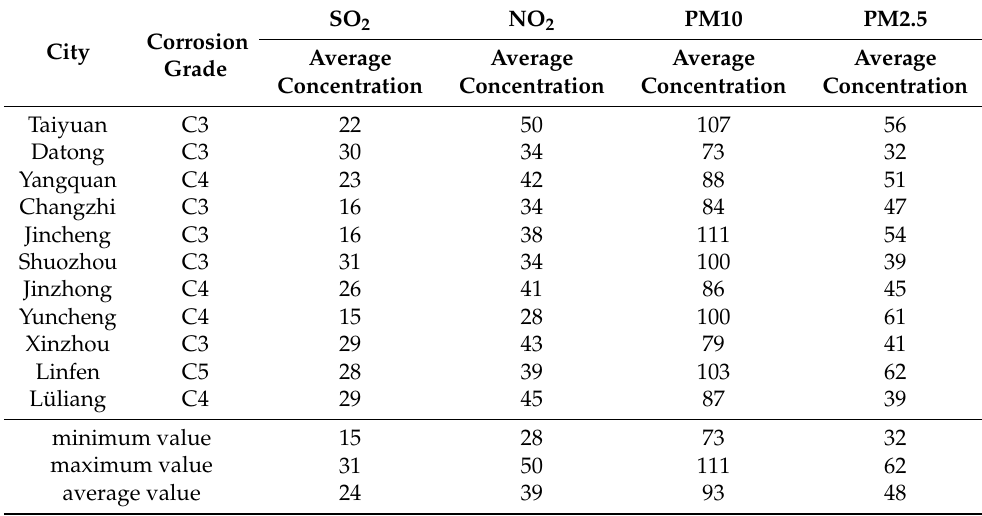
Table 6. Concentration of main pollutants in 11 cities of Shanxi